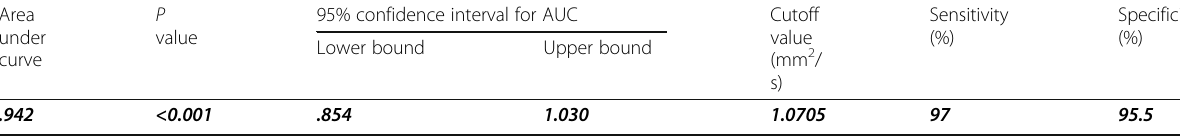
Table 7 The cut off between normal cervical tissue and malignant cervical lesion Area under